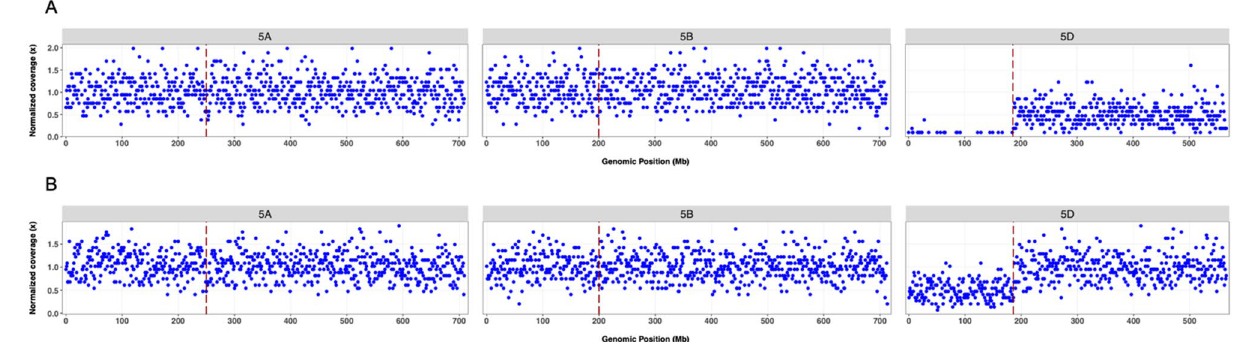
Figure 4. Normalized read counts for example individual samples from Chinese Spring monosomic 5D (CS-M5D; 20 ″ + 1 ′ 5D) populations showing telosomic 5DL [tissue id: DNA200317P02_C03]. ( A ) mono- telosomic 5DL line (20 ″ + t’5DL), carrying only one copy of the 5D chromosome long arm and ( B ) mono- telosomic 5DL [tissue id: DNA200317P02_G01] with one telosomic 5D chromosome (long arm) and one complete 5D chromosome (20 ″ + 1 ′ 5D + t’5DL). The dashed vertical lines indicate the centromere positions based on the IWGSC RefSeq v1 assembly 49